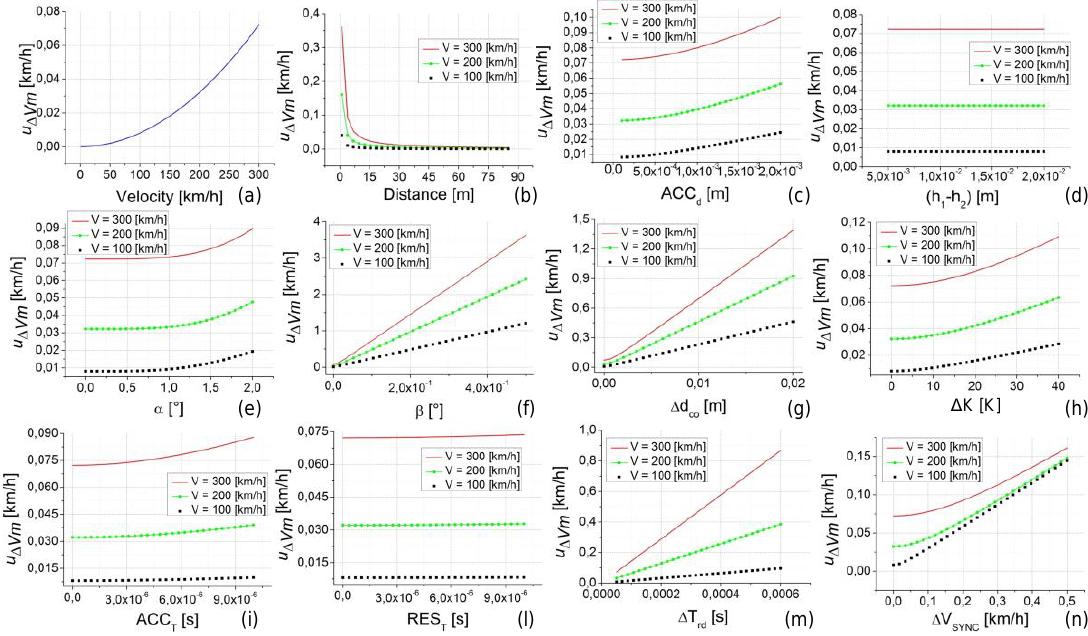
Figure 10. Uncertainty of the calibration method ( 𝑢 ∆𝑉 ) versus the uncertainty contribution parameters. In each plot from ( a – n ) the independent variable is one parameter. The plots are relative to the case study 3 (d = 5 m, speed = 100, 200, and 300 km/h, all the other parameters set to their minimum value, as reported in Table 2).